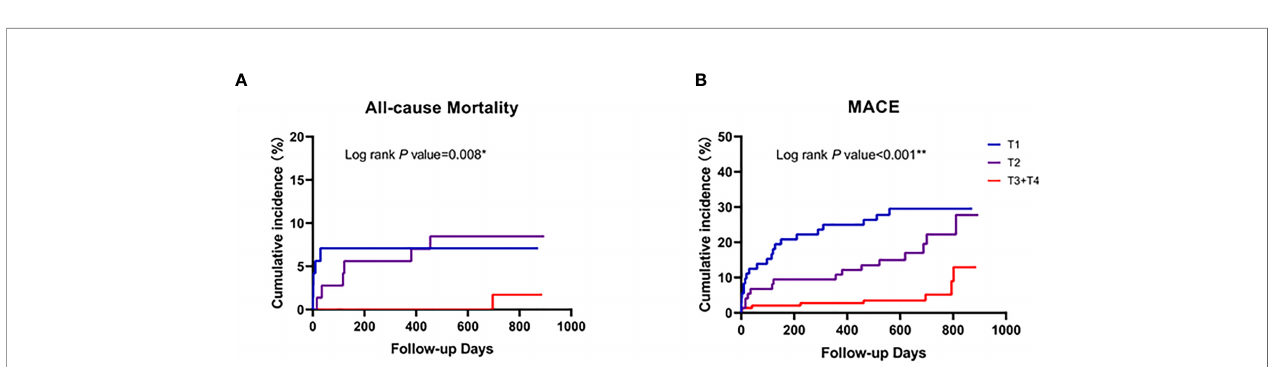
FIGURE 3 | Forest plot to show aHRs and 95% CIs for the all-cause mortality or MACE. (A) upper panel , 18-months all-cause mortality in ACS patients; lower panel , 18-months MACE in ACS patients. (B) upper panel , 18-months all-cause mortality in the STEMI, NSTEMI, and UAP subgroups; lower panel , 18-months MACE in the STEMI, NSTEMI, and UAP subgroups. * p < 0.05; ** p < 0.001.